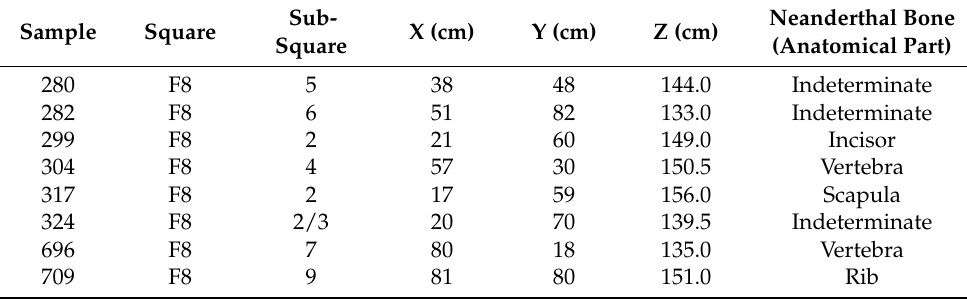
Table 1. Analysed samples indicating their locations in the Ossuary